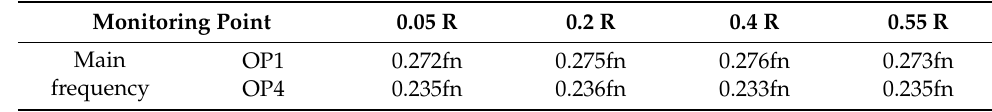
Table 6. Monitoring point instantaneous circumferential velocity pulse main frequency.